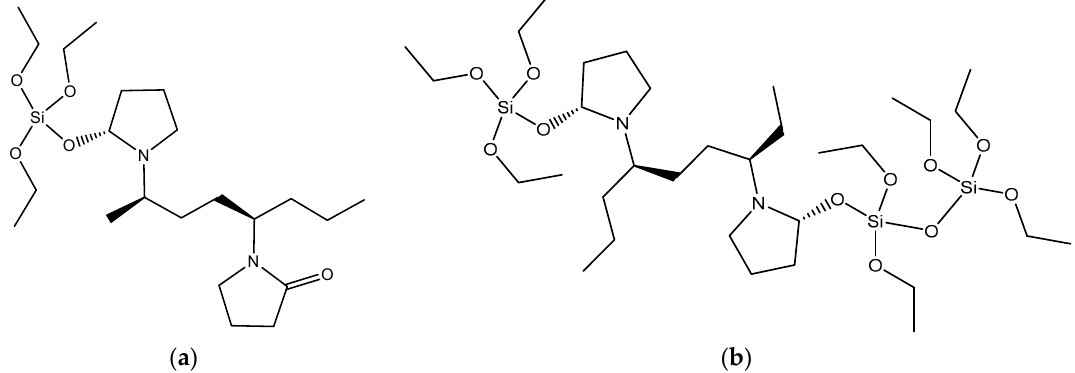
Figure 6. Schemes of the tetraethyl orthosilicate (TEOS) addition to PVP at low ( a ) and high ( b ) concentration.